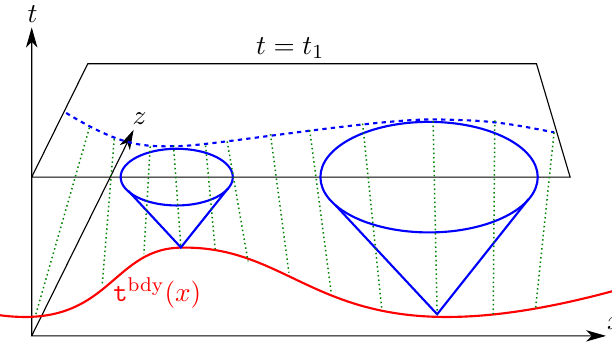
Figure 6 . The solid (red) line is the equal time slice t bdy ( x ) on the boundary, and the dotted (green) lines are the ligthrays emanating from this slice, forming the lightfront that is the boundary of W to the future. The dashed (blue) line is the intersection of the lightfront with the bulk equal-time slice at t = t 1 . Two lightcones are sketched with solid (blue)